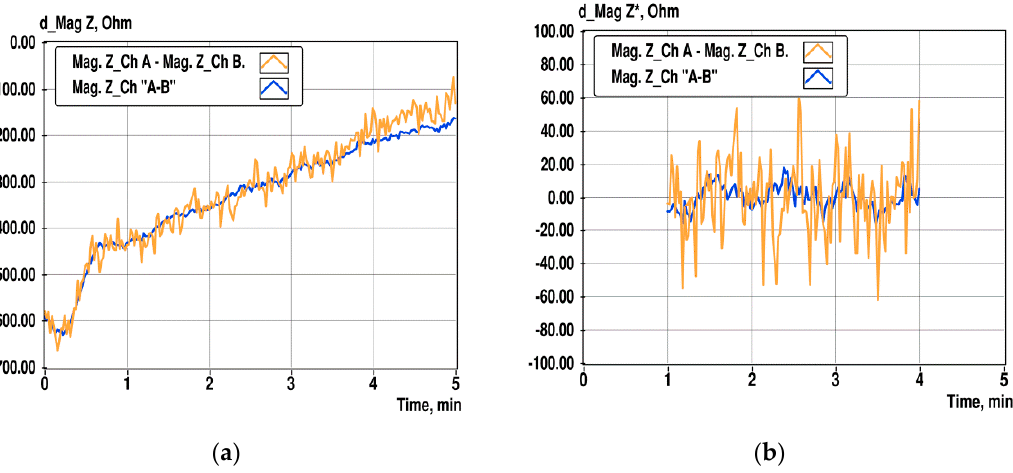
Figure 12. Change of the difference of impedance magnitudes in channels A and B at 10 kHz, and in the differential channel “A-B” during 5 min of observation ( a ), and linearized differences of the same data in the time interval from 1 to 4 min ( b ).